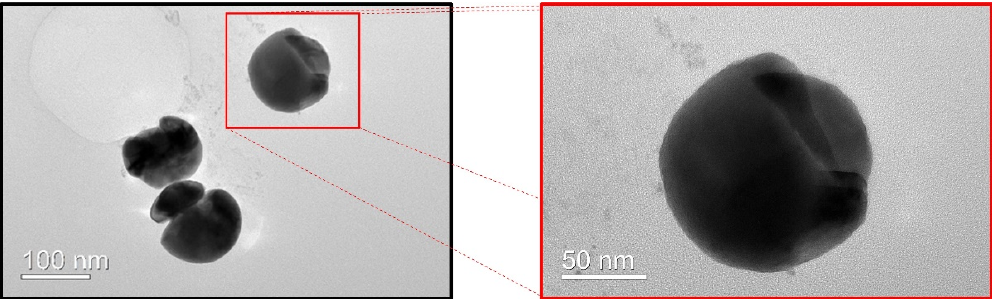
Figure 10. TEM view of CCNPs.